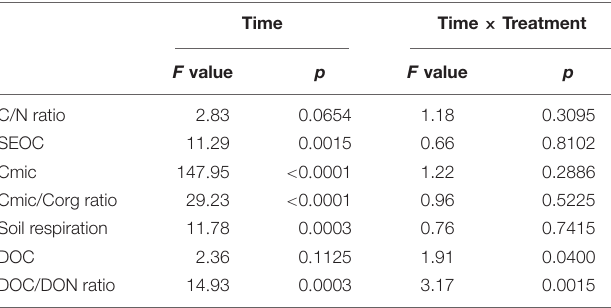
TABLE 3 | Results from repeated measures of ANOVA for the time and time × treatment (agricultural management and earthworm additions combined) effects on the variables investigated: C/N ratio, SEOC (mg C kg − 1 soil dw), Cmic (mg C g − 1 soil dw), Cmic/Corg ratio, soil respiration ( µ g C g − 1 soil dw d − 1 ), DOC (mg kg − 1 soil dw) and the DOC/DON